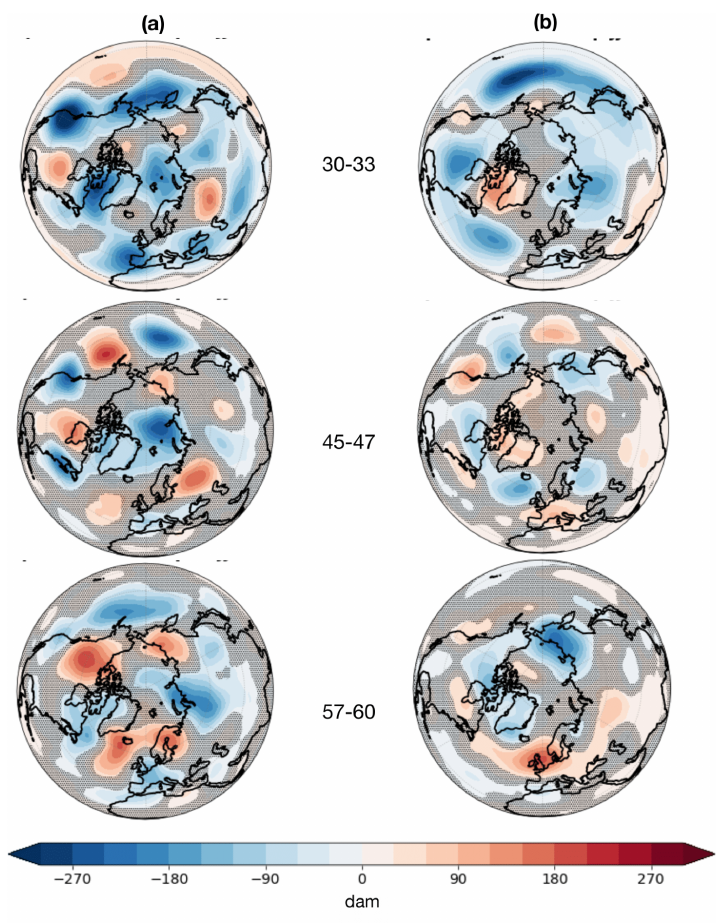
Figure 11. Composite mean of z500 anomalies (in dam) for JJA (a) poleward and (b) equatorward meridional-energy-transport extremes at three chosen latitudinal bands. Non-significant values are shaded in gray. The significance is tested with a bootstrapping method at the 95% significance level. The null hypothesis is that the composite mean value lies within the range of internal